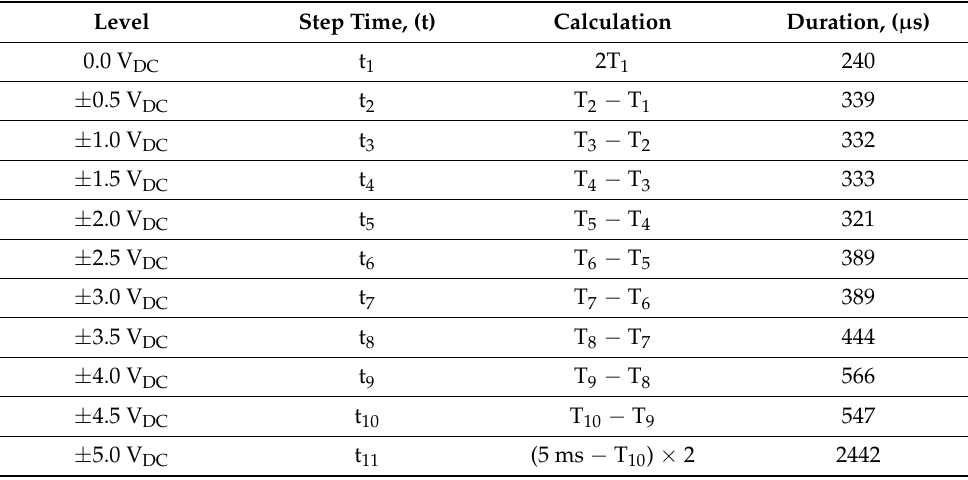
Table 4. Calculation of step-time duration (t 1 –t 11